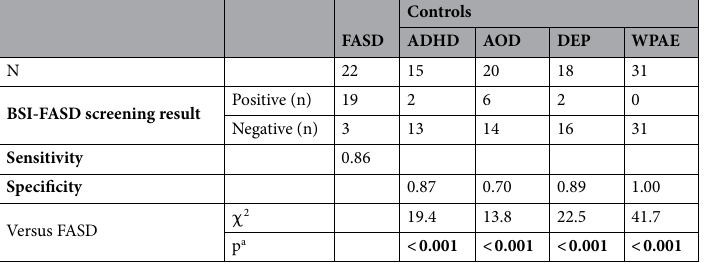
Table 3. Re-analysis using the adapted cut-off point for the Childhood History Domain. The table shows absolute frequencies. P values are derived from a χ 2 tests. P < 0.05 in